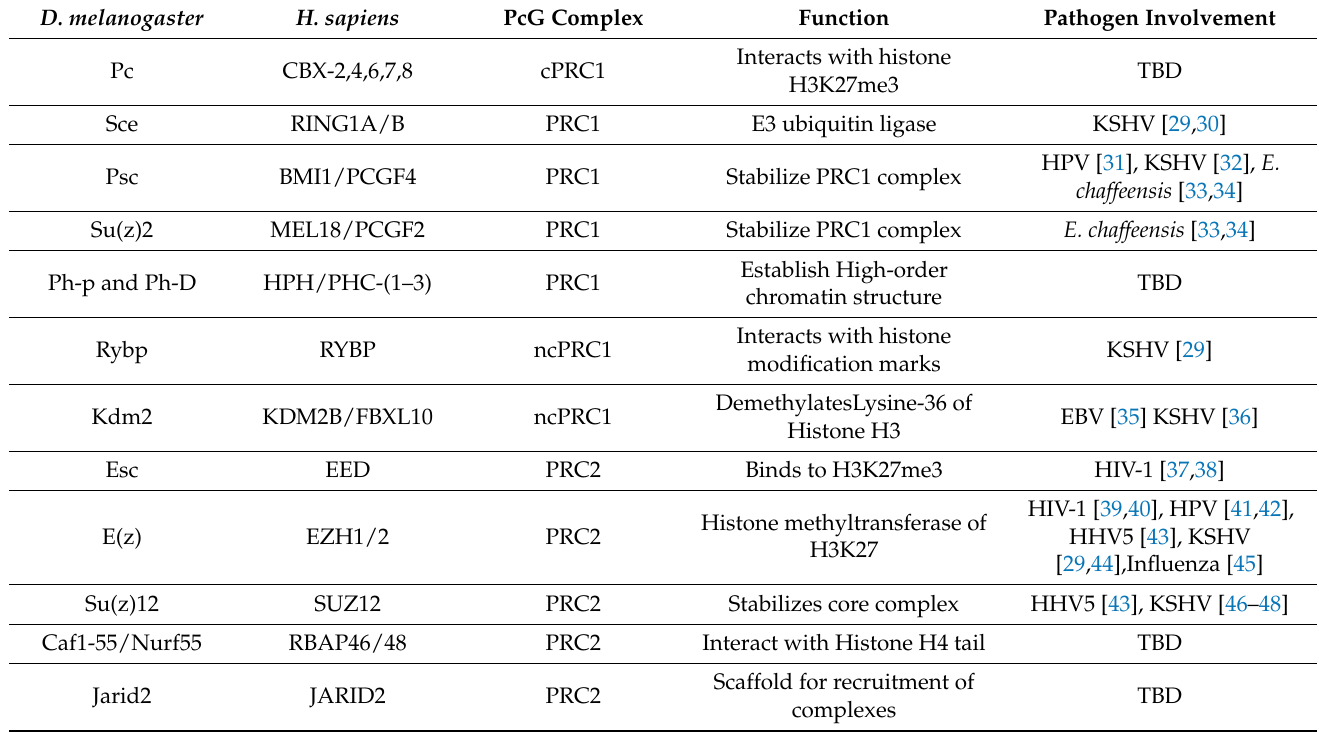
Table 1. PRC subunits, their functions, and pathogen